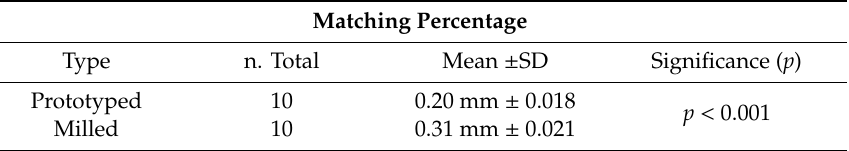
Table 1. Comparative data of deviation analysis (root to mean square (RMS) values) between milled and prototyped splints related to the 3D project. p value based on Student’s t test and set at p < 0.05.